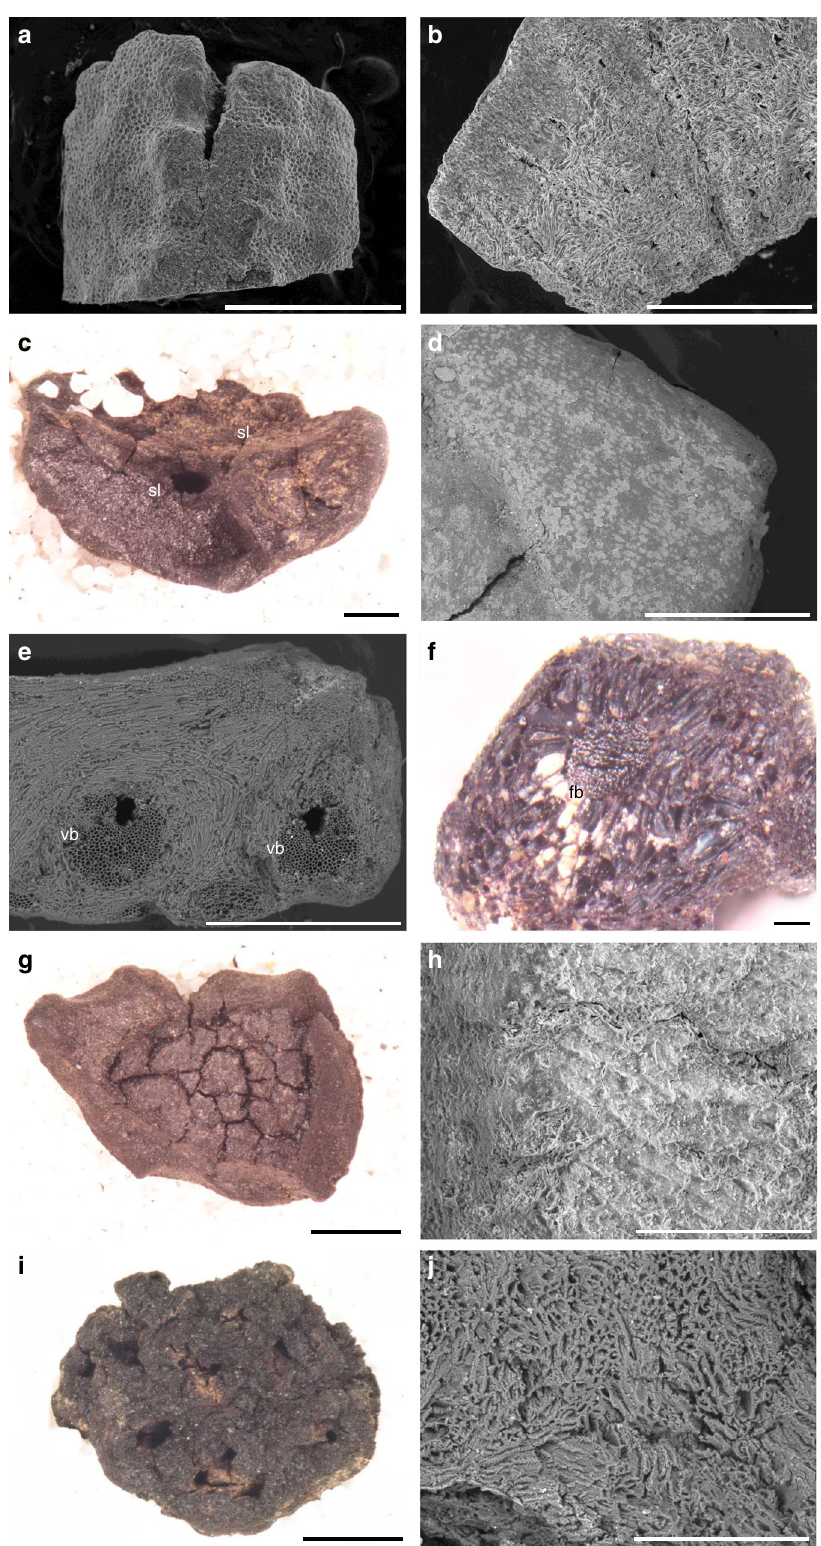
Fig. 2 Examples of endocarp from Phase 2. a , b Buchanania sp. endocarp from C2/46(HR), a scale bar is 1 mm, b transverse section, scale bar is 500 µ m; c Canarium australianum endocarp from C2/38(HR), scale bar is 500 µ m; d C. australianum endocarp from C2/37(HR), close-up of internal surface, scale bar is 500 µ m; e Polydrupe Pandanus sp. endocarp from C2/42(HR), transverse section, scale bar is 500 µ m; f P. spiralis mesocarp from C2/37, scale bar is 200 µ m; g , h Persoonia falcata endocarp from C2/37(HR), g scale bar is 1 mm, h close-up of internal surface, scale bar is 200 µ m; i , j Terminalia sp. endocarp from C2/37(HR), i scale bar is 1 mm, j transverse section, scale bar is 200 µ m. See the supporting online information and Supplementary Figs. 3-7 for detailed identi fi cation proofs and the corresponding reference materials. sl seed locule, vb vascular bundle, fb fi brous